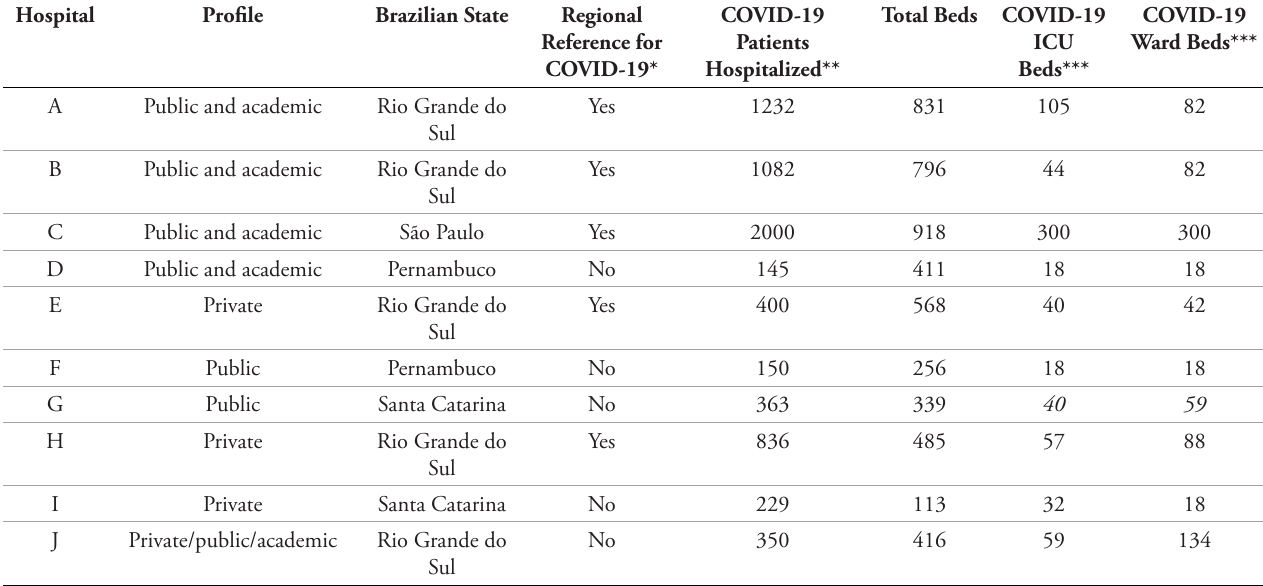
Table 1: Characteristics of Participating Hospitals